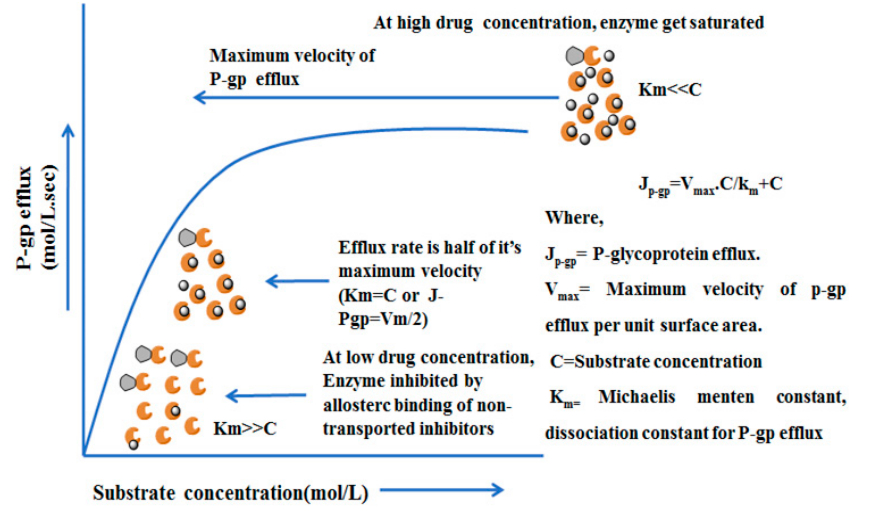
Figure 6. Schematic diagram represents P-gp efflux kinetics [49].